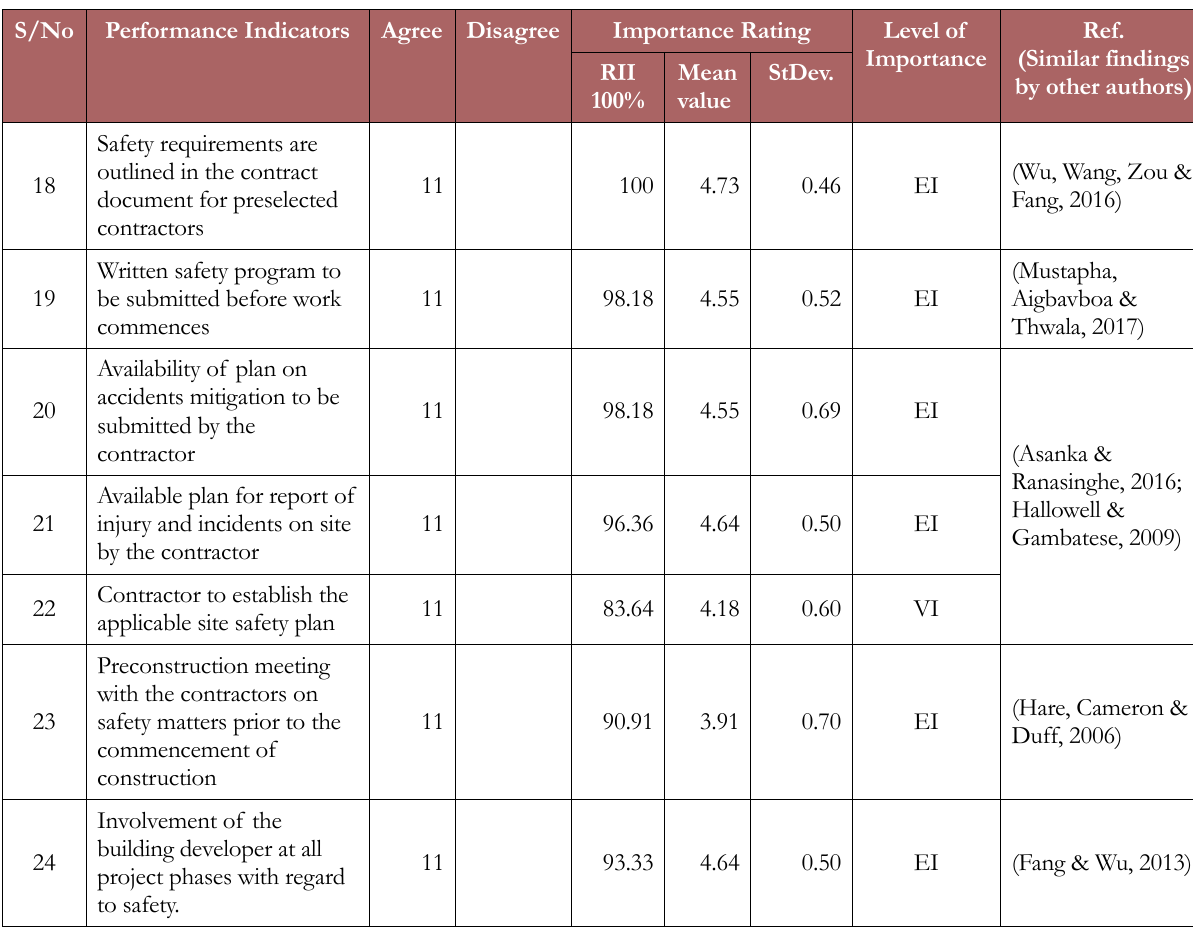
Table 2. Key Performance Indicators for Planning, design and